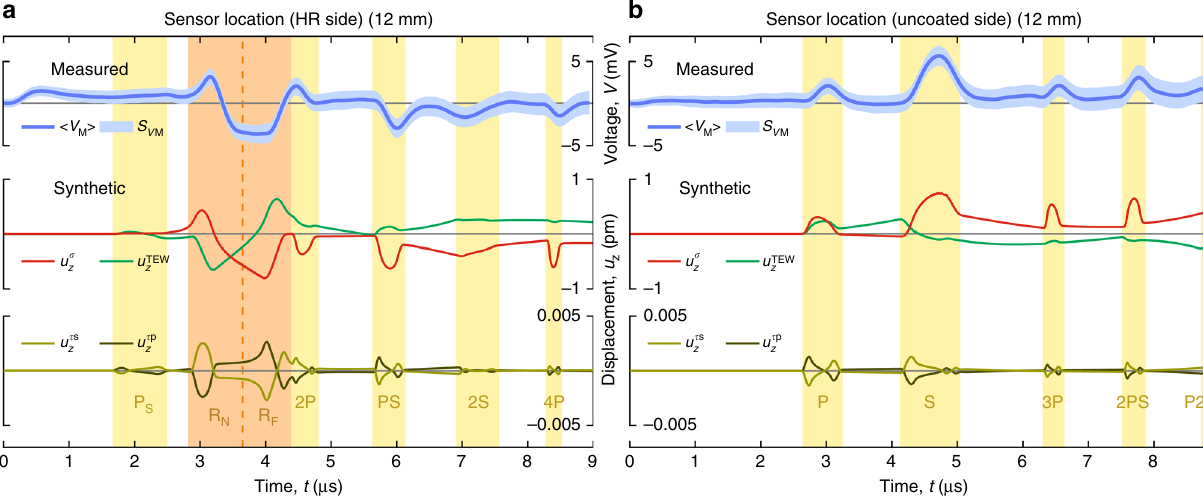
Fig. 5 Comparison between simulated and measured displacement waveforms. The averaged sensor signal 〈 V M 〉 , including the standard deviation S V M at 12 mm beam-center to sensor-center separation distance on the illuminated side of the mirror ( a ) and on the opposite side ( b ) is compared to the calculated synthetic displacements when driven exclusively by normal optical stress (radiation pressure) u σ z ; solely by thermal absorption u TEW z if all of the nonre fl ected light is assumed to be absorbed in the coating; or only by radial optical shear stress (electrostriction as given by the Chu and AMP formalism) for s-polarization u τ s z and p-polarization u τ p z . The features of the measured signal are present in the simulated displacement waveform driven by radiation pressure. Thermoelastic generation yields displacement waveforms that do not match those in the measured signal. Polarization- and EM-formalism- dependent electrostriction yields displacement waveforms with amplitudes that are more than two orders of magnitude smaller, with a shape that does not match the measured signal. These comparisons further suggest that the surface displacement measurements are driven almost exclusively by normal radiation pressure, as opposed to absorption or shear optical